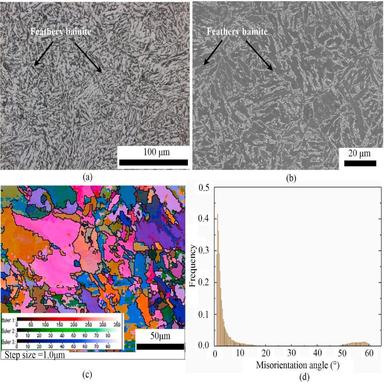
Initial microstructure of SA508steel. (a) Optical and (b) SEM images of the initial microstructural constituent. (c) EBSD map of the initial grain distribution, in which the colour represents the crystal orientation as shown in the legend. (d) The distribution of the misorientation angle obtained from the EBSD analysis. (For interpretation of the references to colour in this figure legend, the reader is referred to the Web version of this article.)